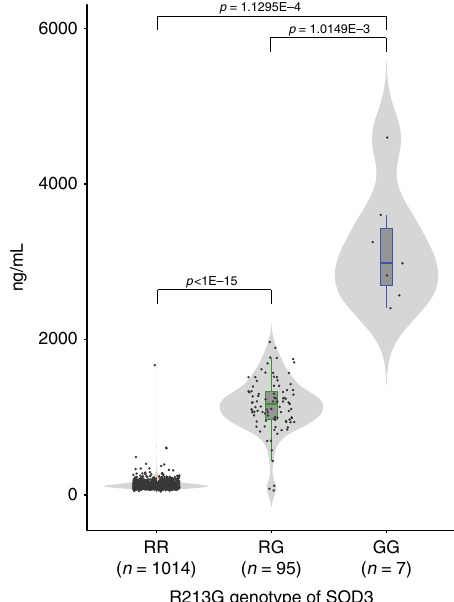
Fig. 1 Plasma extracellular superoxide dismutase concentrations by SOD3 R213G variant (rs1799895). Plasma concentrations of extracellular superoxide dismutase (EC-SOD) were measured in R213G non-carriers (RR, N = 1014), R213G heterozygotes (RG, N = 95), and R213G homozygotes (GG, N = 7). As compared to non-carriers, EC-SOD concentrations were signi fi cantly higher in heterozygotes or homozygotes ( P < 1E − 15, P = 1.1295E − 4, respectively), Violin plots show plasma concentrations of EC- SOD by SOD3 R213G variants. Boxes denote interquartile range, the horizontal lines denote medians, and whiskers denote 10th (lower) and 90th (upper) percentiles. P values are from one-way ANOVA with post hoc Bonferroni